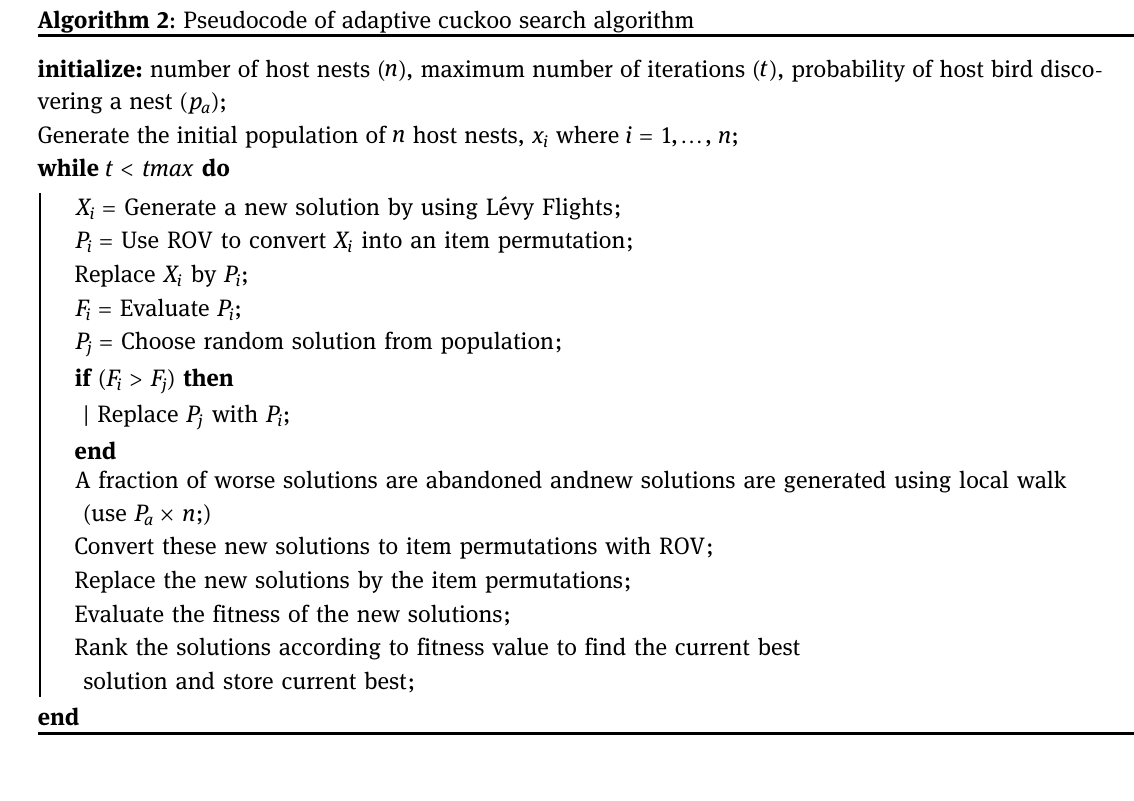
Algorithm 2 : Pseudocode of adaptive cuckoo search